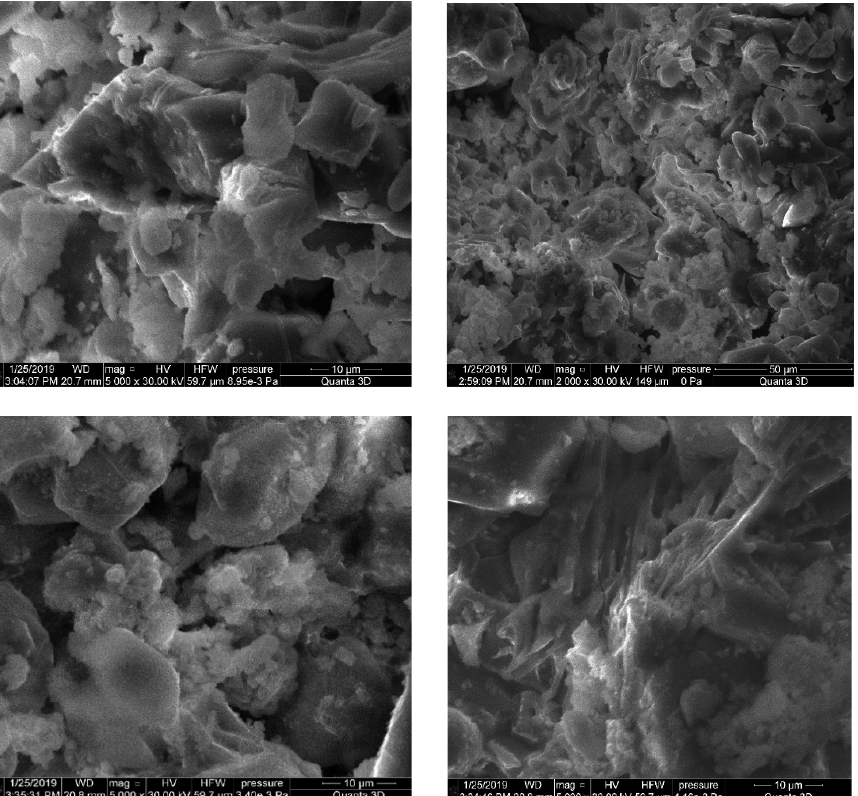
Figure 3. EDS spectra phases of the dusts: ( a ) clinker, and ( b ) aspiration. The SEM images in Figures 3 and 4 present a comparative analysis of the electrostatic precipitators’ dust structures. Grains of clinker dust at a magnification of 5000 times are represented by coarse volumetric particles with pronounced cleavage, and the clear presence of minerals is observed (Figure 4). The microstructure of clinker dust grains is represented by alite and belite crystals and a fine-grained intermediate phase, and there are separate rounded CaO crystals, angular MgO, and pores. The alite crystals are characterized by the appearance of hexagonal or rectangular prisms, while the belite crystals have jagged edges and a rounded shape. Between the alite and belite crystals is an intermediate substance belonging to calcium aluminoferrites, tricalcium aluminate, and clinker glass. The pores look like “wells” of irregular shape and are clogged with iron oxide.